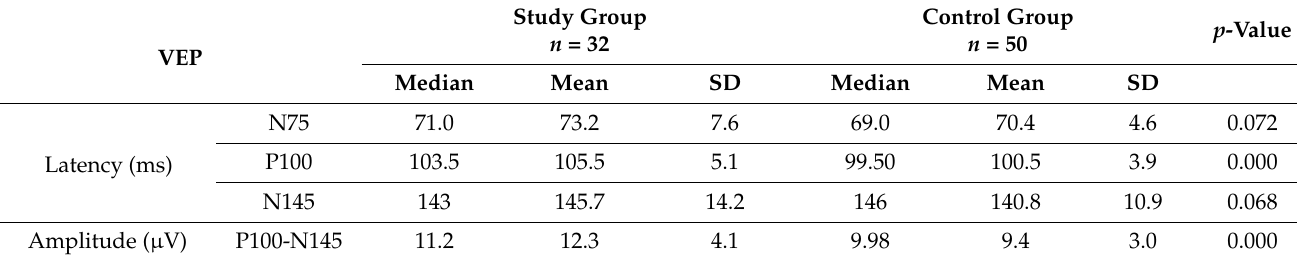
Table 2. Visual evoked potentials in the study group and in the control